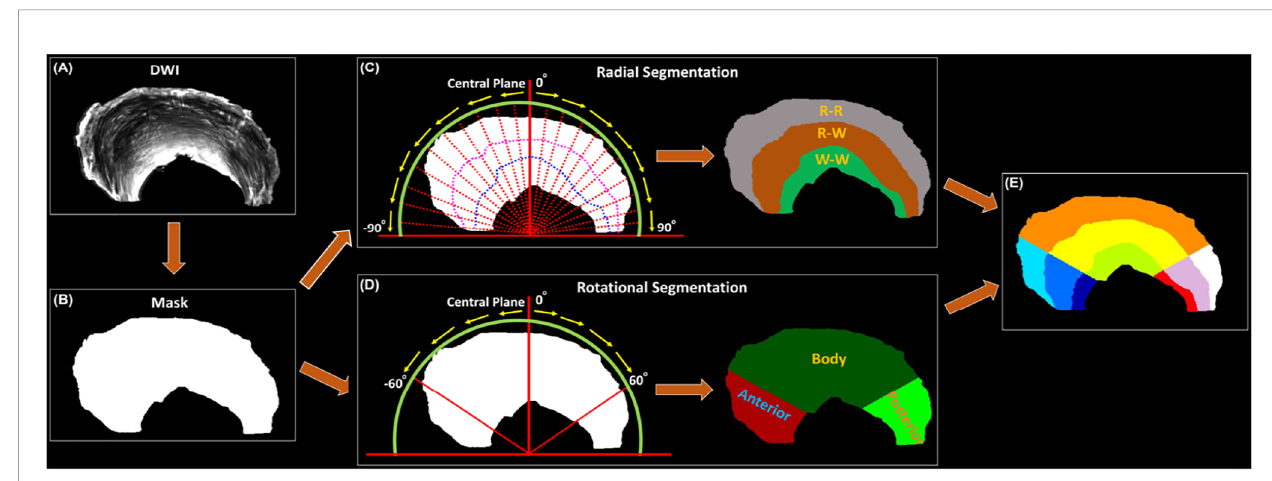
FIGURE 1 | The automatic segmentation process used in this study, from the acquired DWI (A) to the 9 different areas of meniscus (E) . Both Radial Segmentation (C) and Rotational Segmentation (D) were derived from the binary mask (B) . These two methods were further combined to divide the whole meniscus to 9 regions (E) . R-R, Red-Red zone; R-W, Red-White zone; W-W, White-White